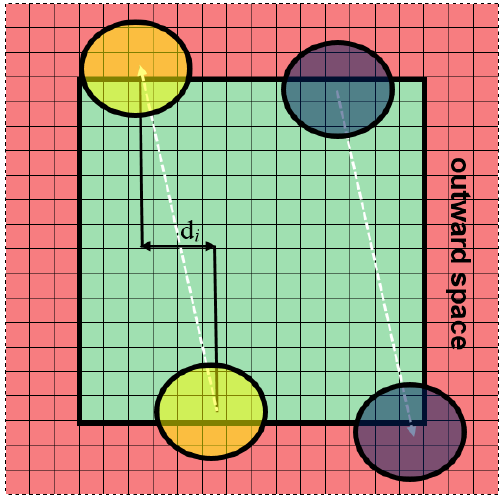
Figure 5. Periodic boundary conditions with displacement.